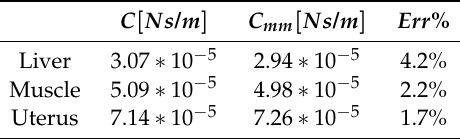
Table 5. Comparison between the effective viscous damping and those obtained by the